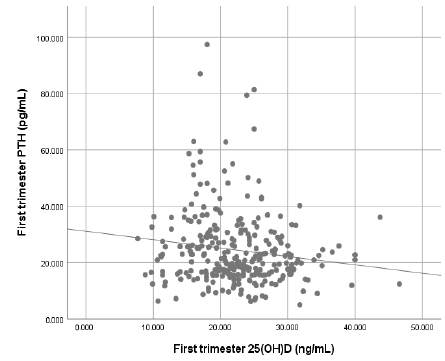
Figure 2. Scatter plot of the correlation between parathyroid hormone and vitamin D. PTH: parathyroid hormone; 25(OH)D: 25-hydroxyvtiamin